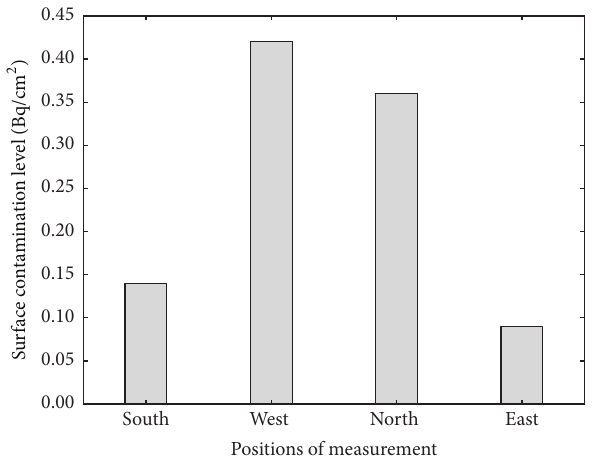
Figure 8: Surface contamination level near the middle part of the removed helium circulator during the maintenance.